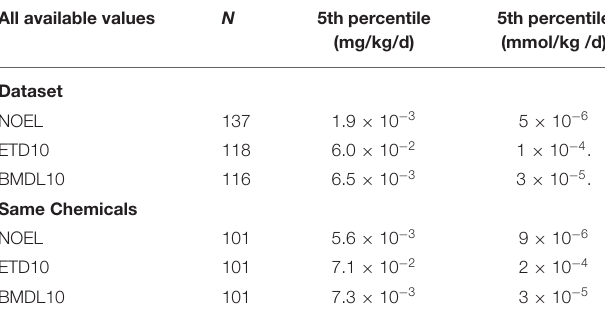
TABLE 3 | Fifth percentiles for NOEL, ETD10, and BMDL10